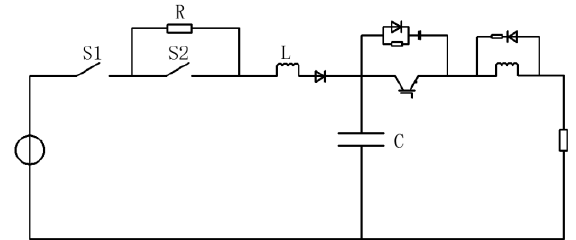
Fig. 4. The charging equivalent circuit with the soft-start